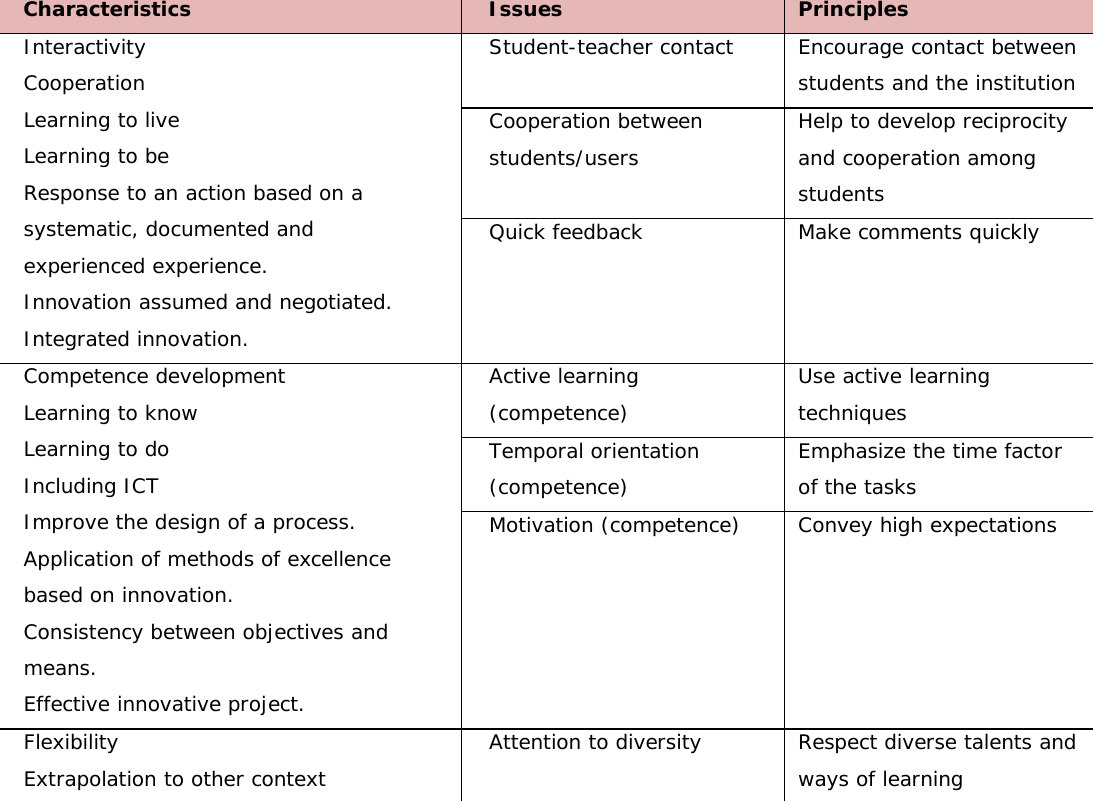
Table 1. “Characteristics, issues and principles of education”. Source: Compiled from González and García